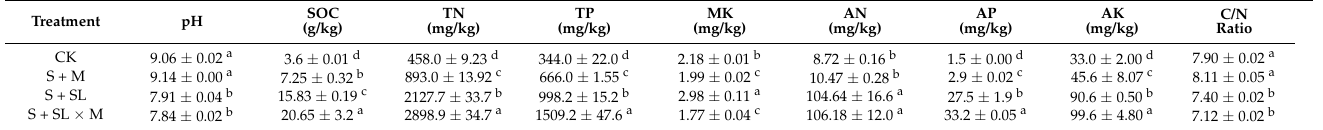
Table 2. Effects of different treatments on chemical properties of the